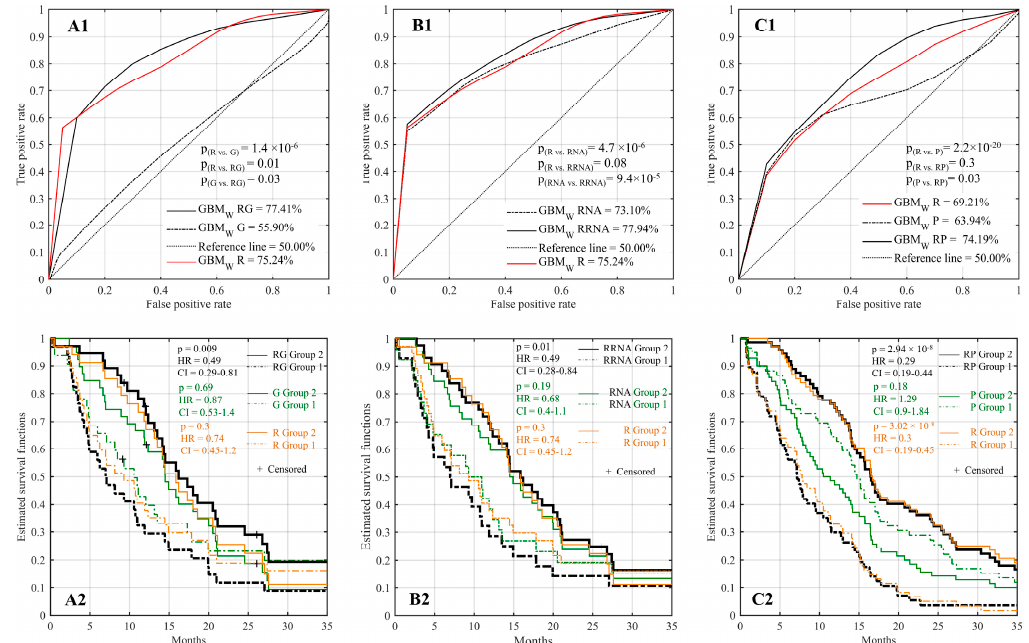
Figure 2. Multivariate prediction models integrating radiomics with genomic, transcriptomic or protein expression-immunohistochemistry (IHC) analysis. Using The Cancer Imaging Archive (TCIA)/The Cancer Genome Atlas (TCGA) datasets (n = 71), ( A1 ) Area under the Receiver Operating Characteristic(ROC) curve of genomics alone (GBMw G), radiomics alone (GBMw R) or when using a combination of genetic and radiomic features (GBMw RG). ( B1 ) Area under the ROC of the transcriptome alone (GBMw RNA), radiomics alone (GBMw R) or when using a combination of transcriptomic and radiomic features (GBMw RRNA). Kaplan – Meier estimate for the TCGA patient cohort when analyzed using the radiomics/genomics ( A2 ) or radiomics/transcriptomic ( B2 ) models. Using our internal McGill University Health Centre (MUHC) cohort (n = 129), ( C1 ) Area under the ROC of either proteins alone (GBMw P), radiomics alone (GBMw R) or when combining radiomics with IHC features (GBMw RP). ( C2 ) Kaplan – Meier survival of patients analyzed with the combined radiomics/IHC prediction model. Significance p-value derived from chi-square test ( A1, B1, and C1 ) for comparing the predicted survival groups corresponding to